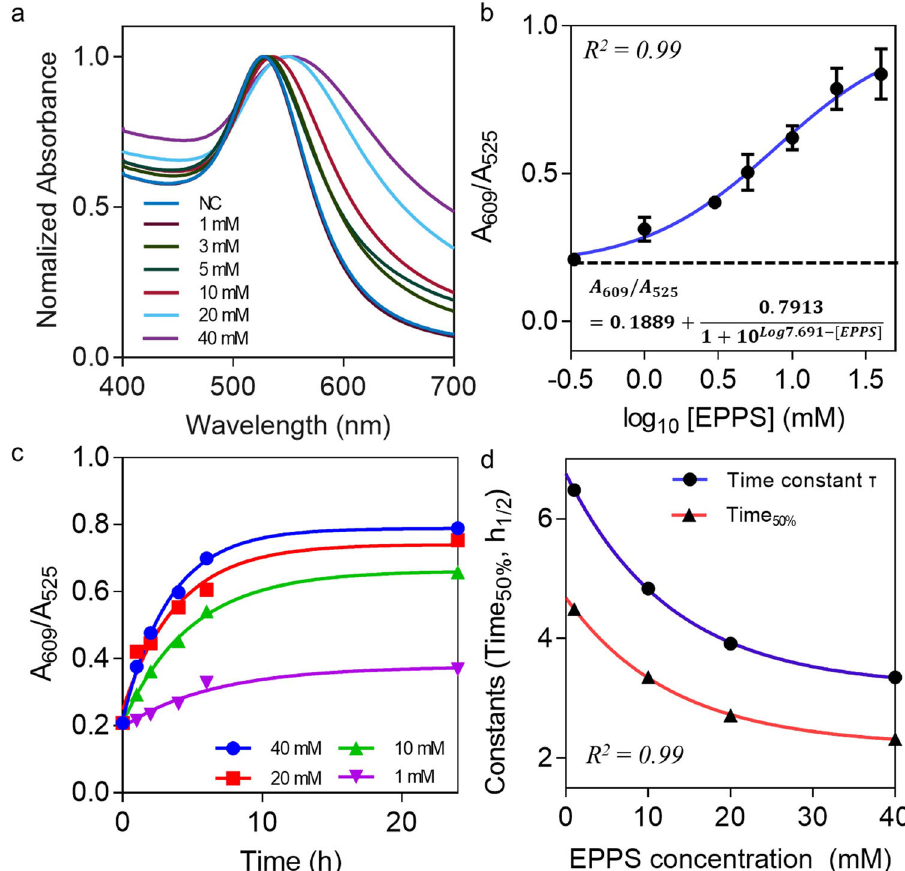
Fig. 4 Kinetic analysis of A β -degrading agent (EPPS). a UV – vis spectra of PNAC solution depending on EPPS concentration (0, 1, 3, 5, 10, 20, and 40 mM). b A 609 /A 525 of PNAC solution depending on the concentration of EPPS. c A 609 /A 525 of PNAC solution depending on the reaction time (1 – 24 h) with various concentrations of EPPS. d The kinetic analysis of the degradation of oligomeric aggregate depending on the EPPS concentration. Dot plots in b represent the average ± standard deviation calculated from n = 3 independent samples. Source data are provided as a Source Data fi